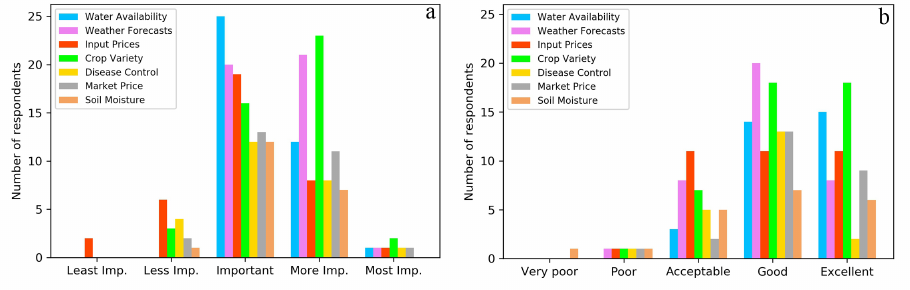
Figure 3. Farmer perception on ( a ) the importance of weather and water-related information and ( b ) the quality of weather and water-related information. Acronym Imp stands for